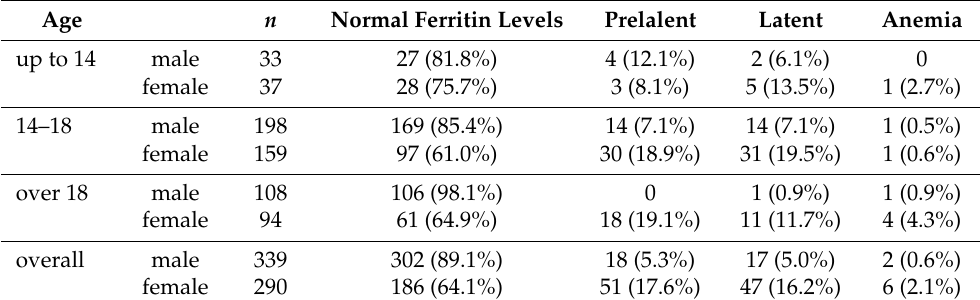
Table 1. Age-group comparison of iron status.